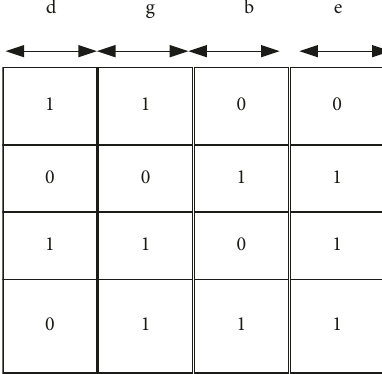
Figure 2: Chromosome structure.